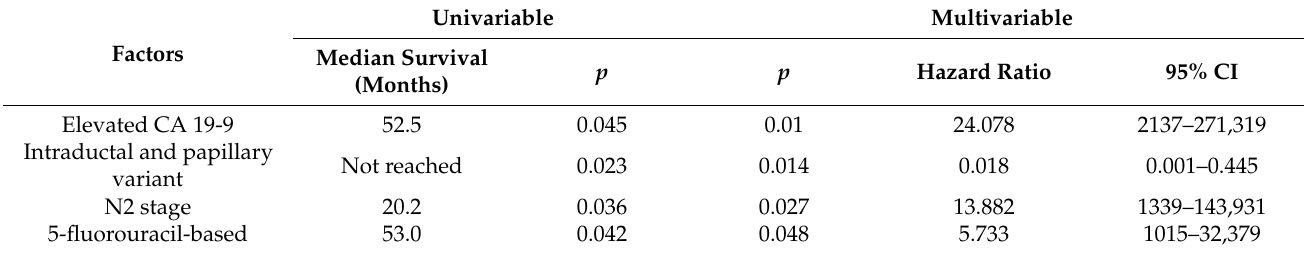
Table 2. Survival analysis for identifying factors affecting patients’ overall survival using a Cox proportional hazard model.